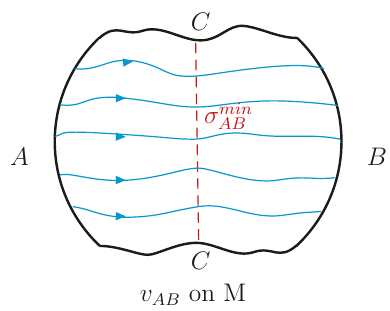
Figure 2 . Sketch of vector (cid:12)eld v AB on Riemannian manifold M . A; B are the regions on the boundary @M , and C = AB := @M n ( AB ) is the complement of AB ( (cid:17) A [ B ). The (cid:13)ow v AB is only non-vanishing on A and B . Therefore, the (cid:13)ux of any (cid:13)ow from A to B is bounded above